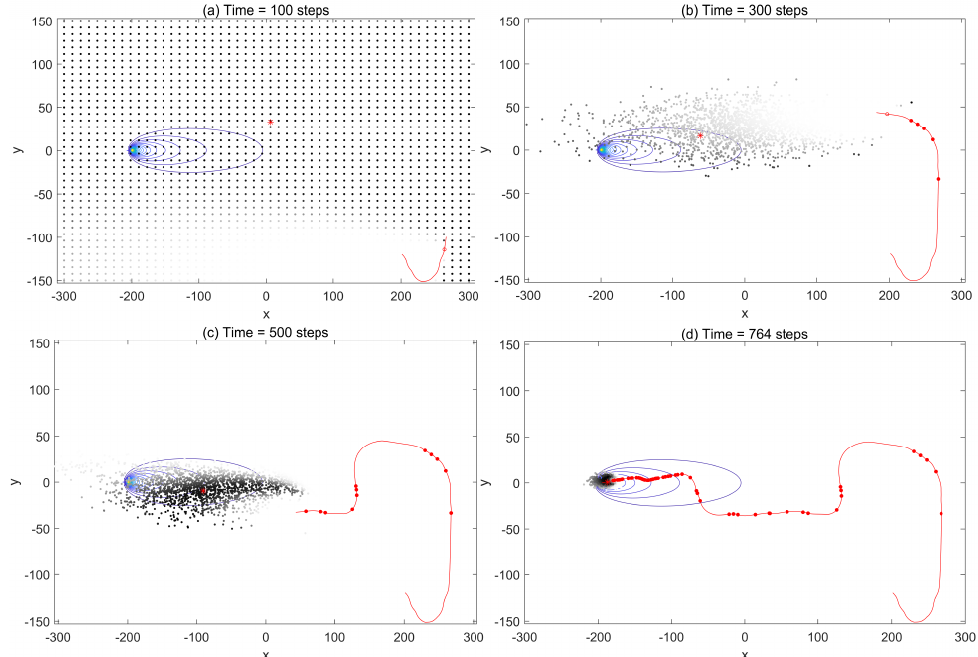
Figure 2. The trajectory, detections, and particles of the mobile sensor platform at the times k = 150, 350, 550, 764 using the free energy scheme. The source location at ( − 200,0 ) with the contour plot of the corresponding mean rate.